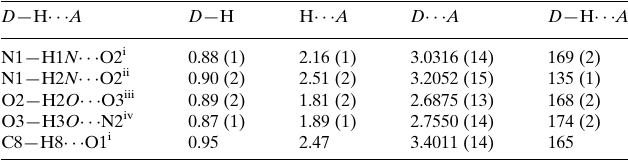
Hydrogen-bond geometry (A˚ , (cid:2)